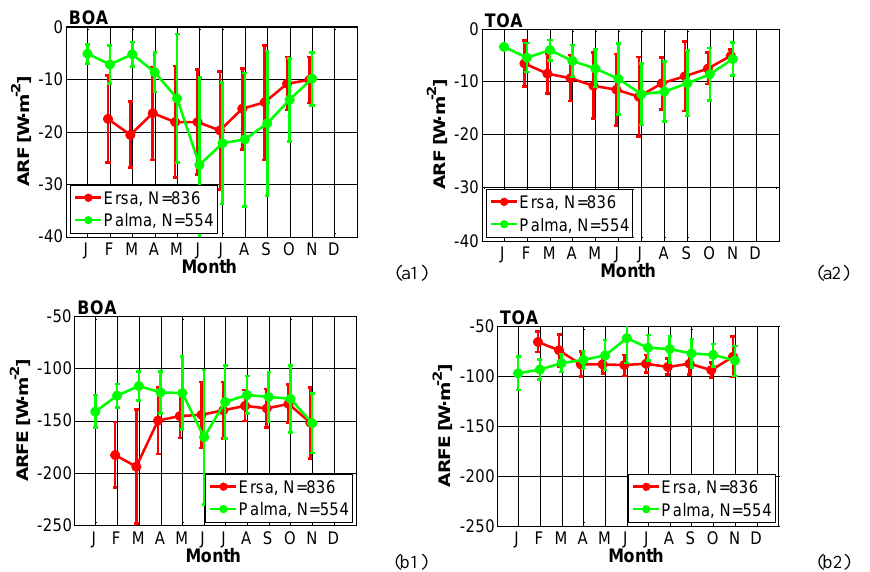
Figure 12. Monthly variation of (a) the solar aerosol radiative forcing (ARF) and (b) the solar aerosol radiative forcing efficiency (ARFE) at the (1) bottom of the atmosphere (BOA) and (2) top of the atmosphere (TOA), derived from AERONET level 2.0 inversion products available for the period 2011–2015. Both the ARF and the ARFE are estimated for 50 ≤ solar zenith angle ≤ 60 ◦ . The error bars represent the standard